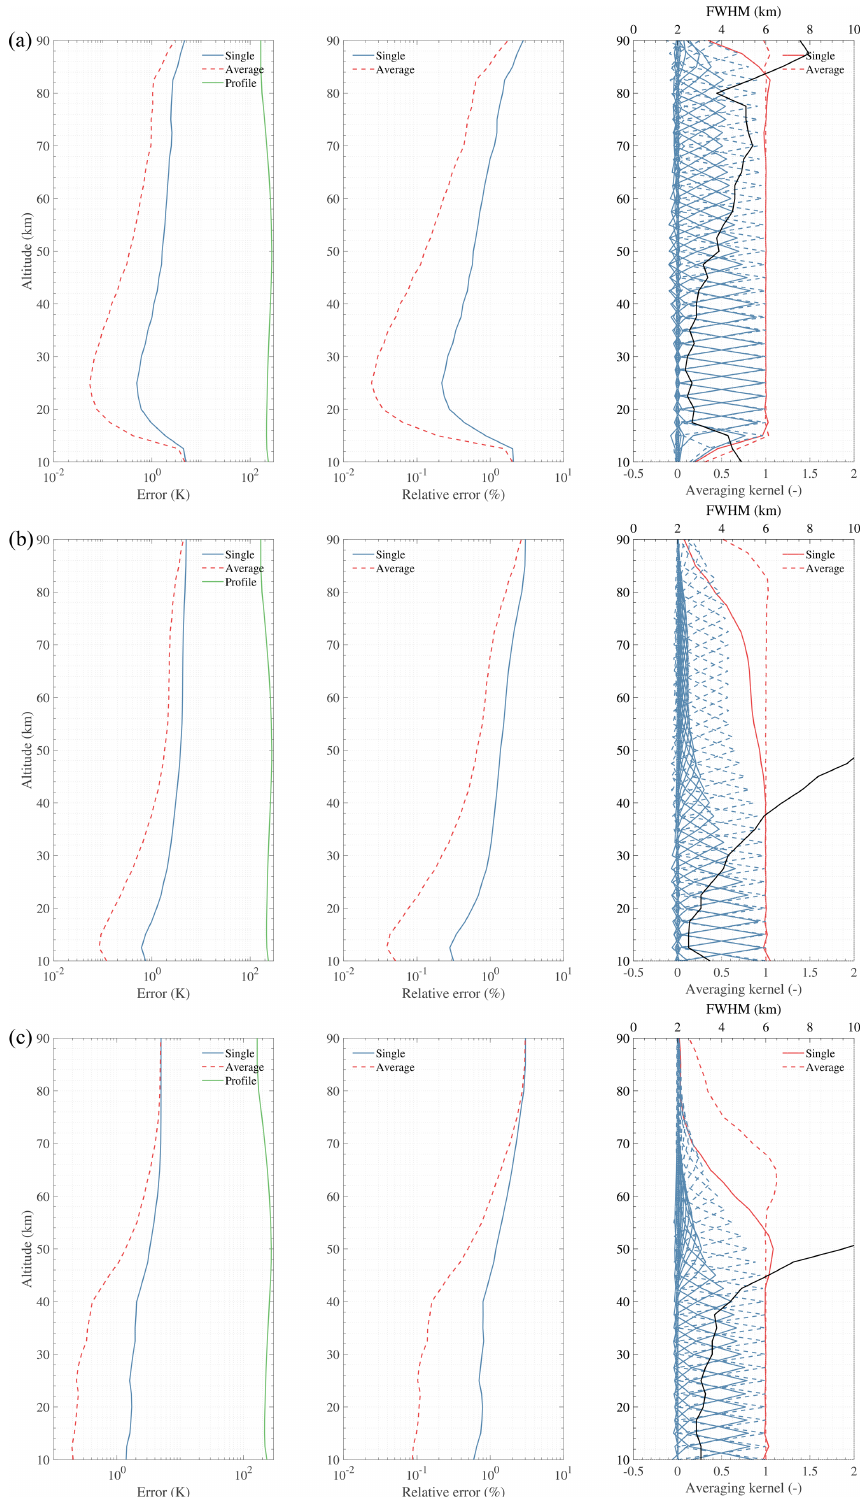
Figure 12. Simulation results of temperature retrieval using 118.75 (a) , 233.95 (b) , and 627.75GHz (c) lines. “Single” and “Average” represent the retrieval error using different noise. “Profile” represents the typical profile used in the simulation. The black solid line in the last panel represents the FWHM (i.e. vertical